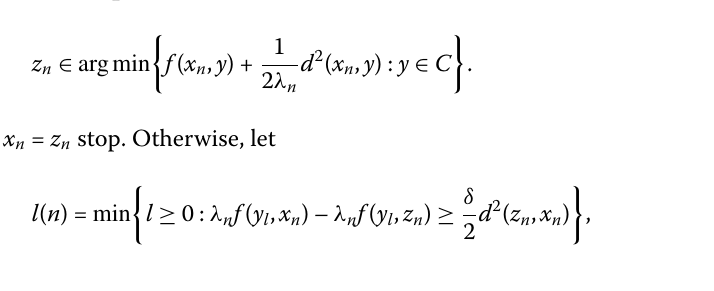
Algorithm 1.1 (Extragradient Algorithm with Linesearch